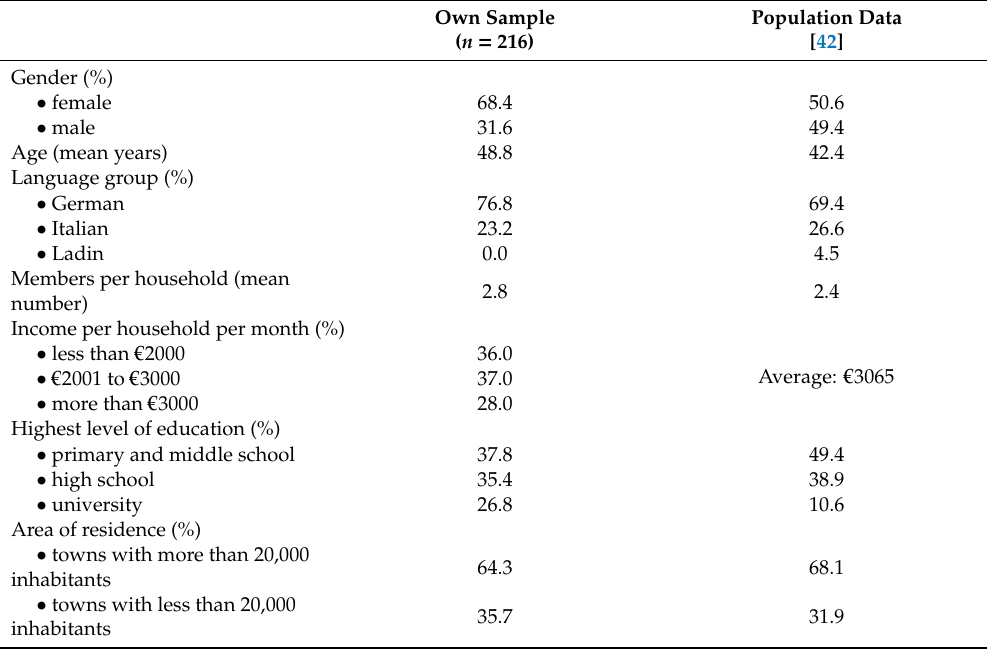
Table 2. Sociodemographic characteristics of the sample compared to the population data for the Province of Bolzano.